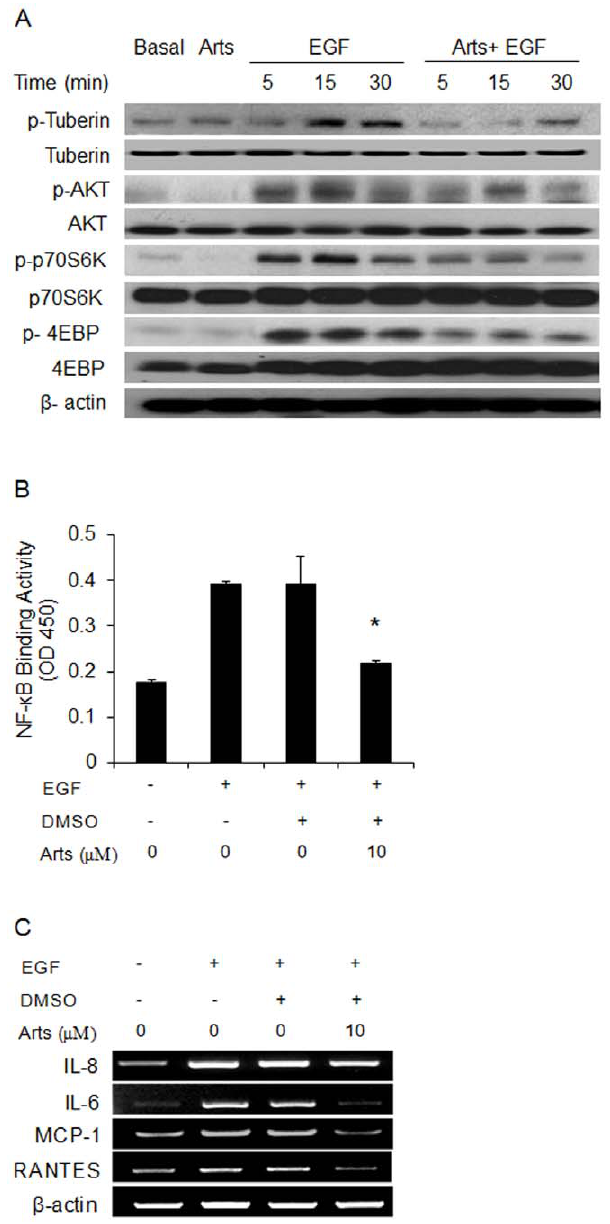
Figure 6. Effects of artesunate on EGF stimulation of normal human bronchial epithelial cells. (A) Epithelial cells were stimulated with 100 ng/ml EGF in the presence and absence of 10 m M artesunate for 5, 15 and 30 minutes before total proteins were extracted for subsequent immunoblotting analysis. b -actin was used as an internal control. (B) DNA-binding activity of p65 NF- k B in nuclear extracts of epithelial cells stimulated with EGF for 30 minutes in the presence and absence of 10 m M artesunate was determined using a TransAM TM p65 transcription factor ELISA kit. (C) Epithelial cells were stimulated with 100 ng/ml EGF in the presence and absence of 10 m M artesunate for 12 hours before total mRNA was extracted using TriZol reagent. PCR products were separated in a 2% agarose gel and visualized under UV light. b -actin was used as an internal control. Representative gels from 4 separate experiments with similar pattern of results. Values shown are the mean 6 SEM of three separate experiments. *Significant difference from DMSO control, p , 0.05.